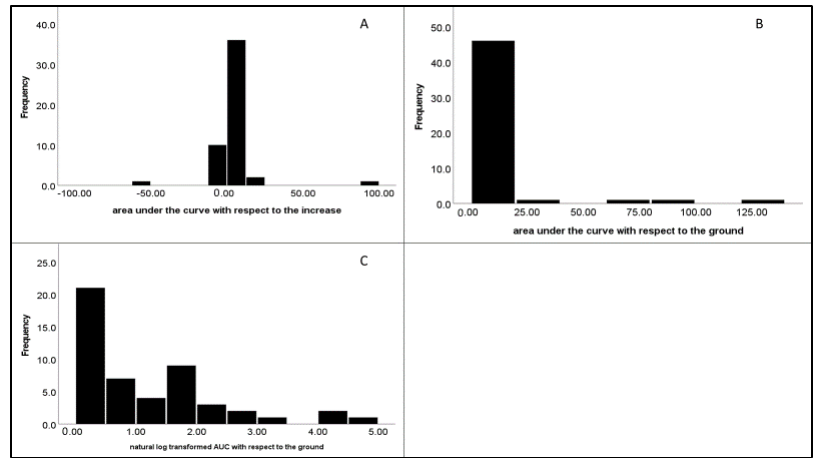
Figure 1. Observed and estimated trajectories from the ZIP LGCM for the N = 50 simulation.